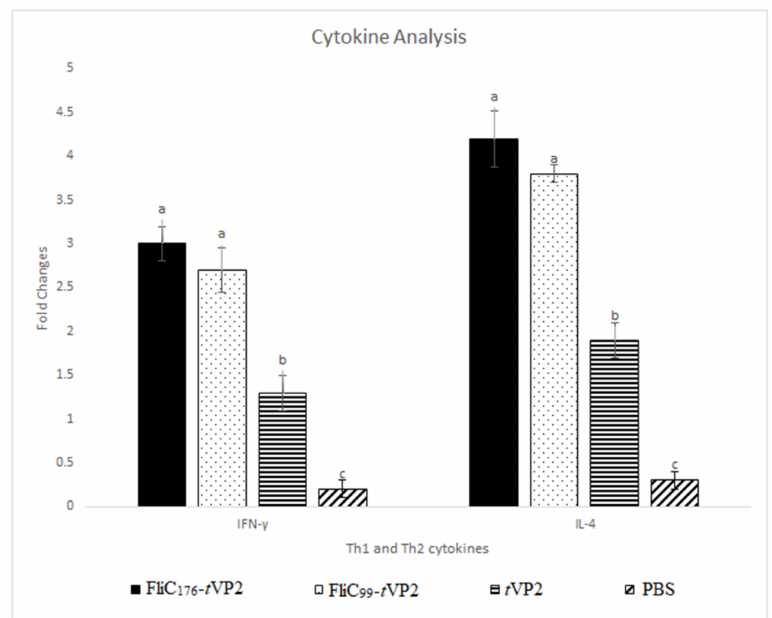
Figure 6. Peripheral blood mononuclear cells (PBMCs) were taken from chickens (number of chickens in each group = 3) and treated with 10 µ g/mL of the tVP2. Expression levels of the cytokines, such as IFN- γ and IL-4, were determined. Data are presented as mean ± SEM. Different letters indicate significant differences ( p < 0.05) between treatment groups at the same time point.